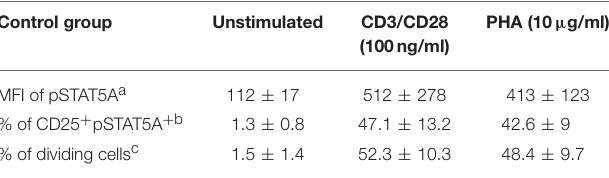
TABLE 4 | Summary of MFI of pSTAT5A, % of CD25 + pSTAT5A + cells and % of dividing cells in CD3/CD28 or PHA stimulated cells for healthy adult controls ( n =